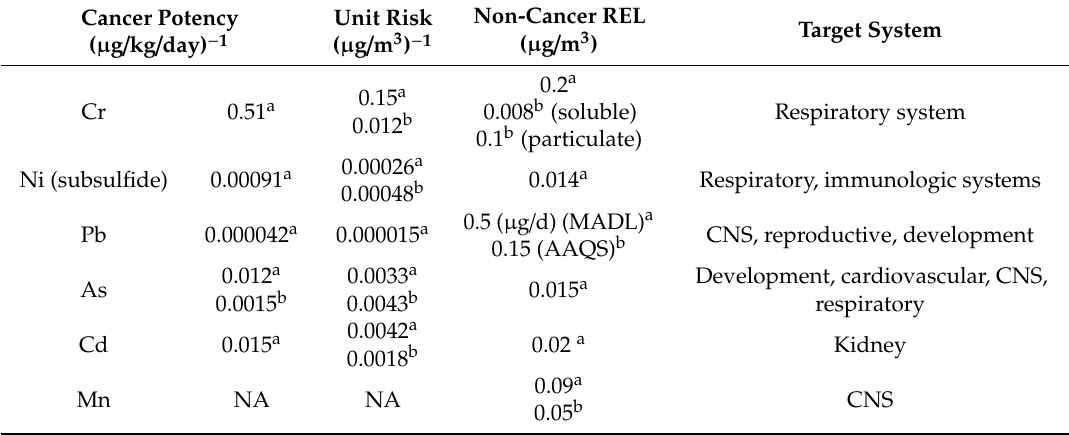
Table 2. Cancer potency slope factors and non-cancer reference exposure levels used for risk assessment of metals in e-cigarette